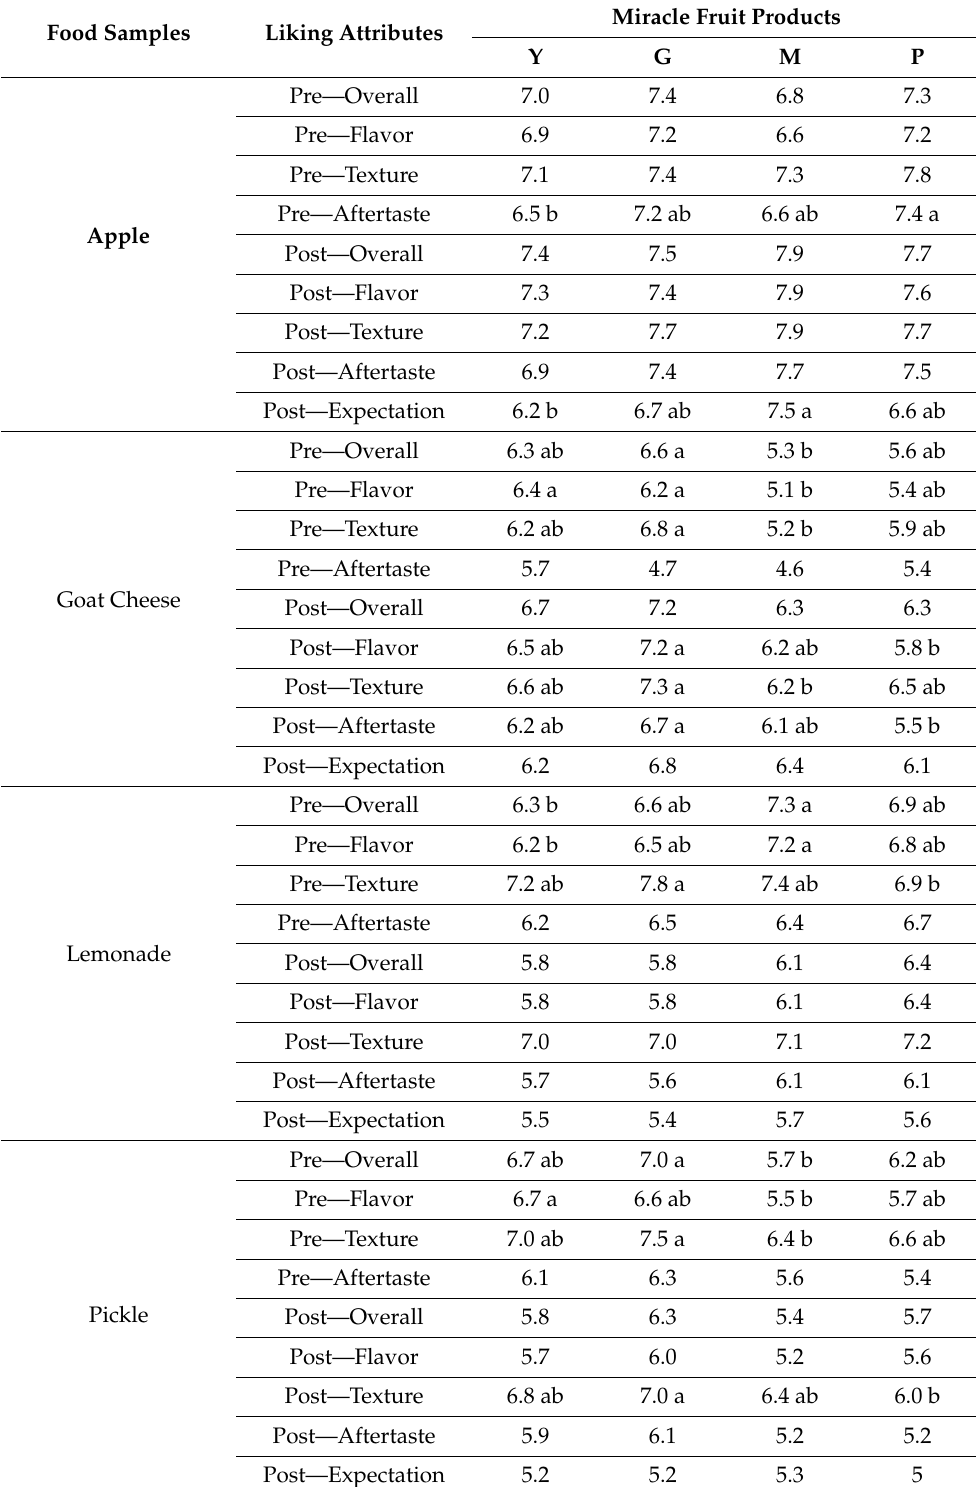
Table A1. Multiple comparisons of liking attribute means of pre- and post-test intensity for each food sample and miracle fruit product (Y, G, M, and P product details given in Table